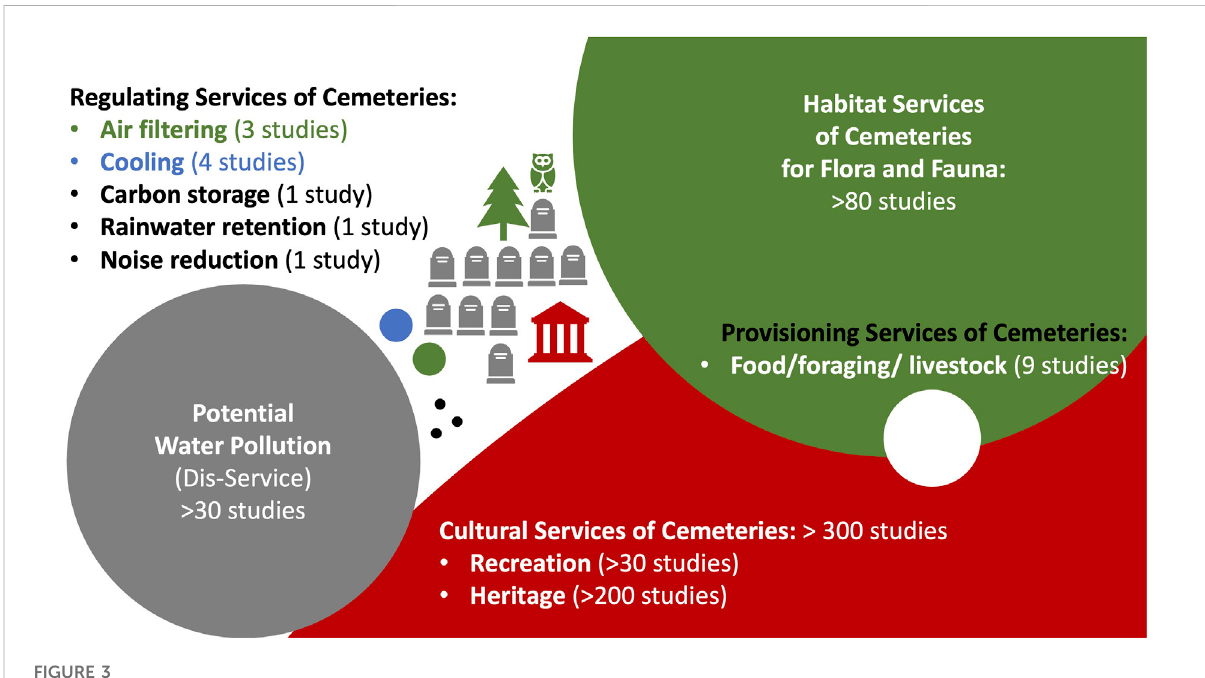
FIGURE 3 Overview of studies on ecosystem services provided by urban cemeteries. The diameter of each circle is related to the number of studies identi fi ed per (dis)